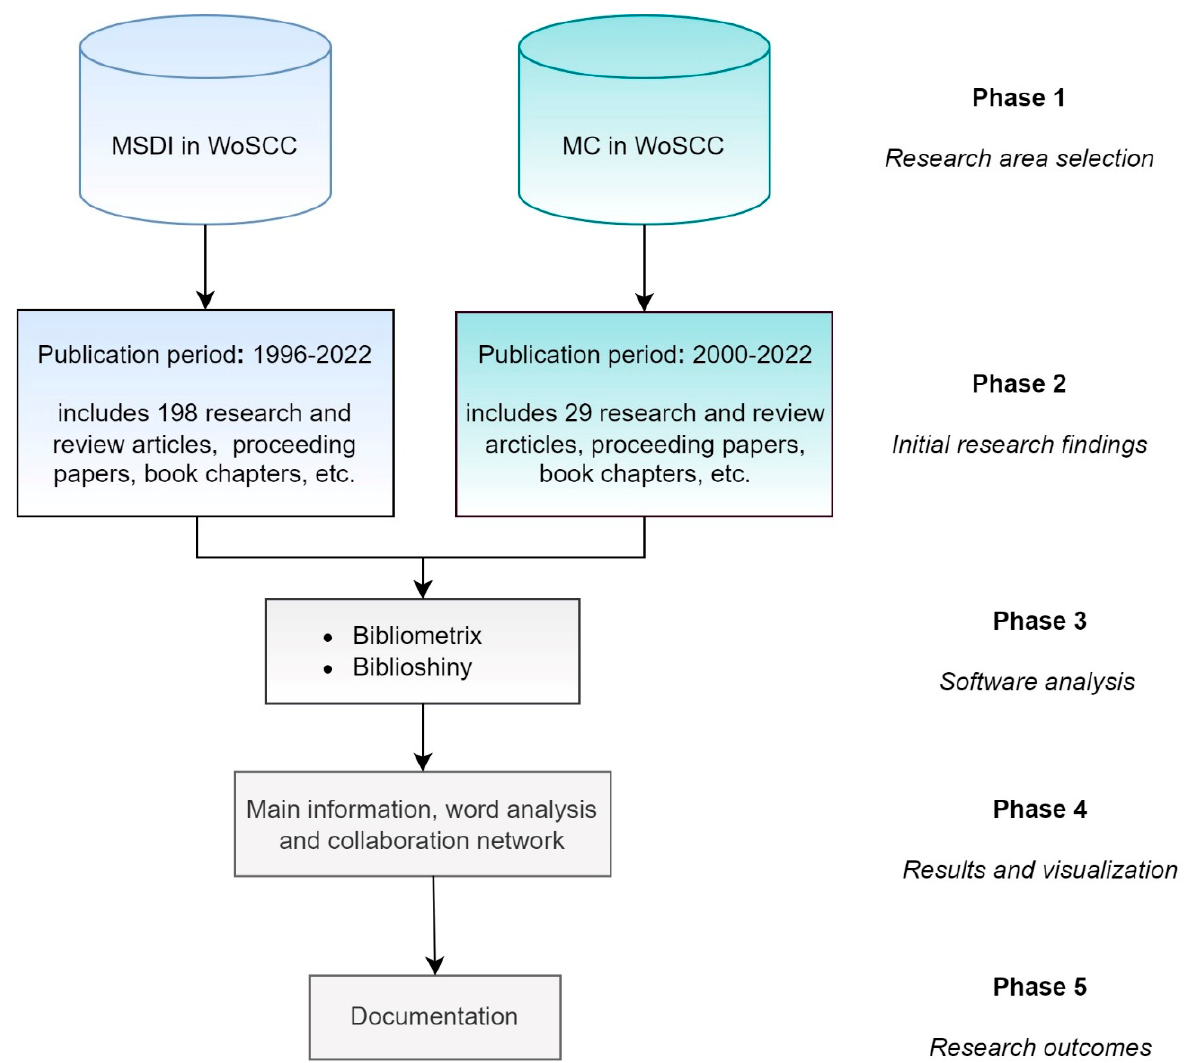
Figure 1. Flow diagram of bibliometric evaluation methodology of MC and MSDI.